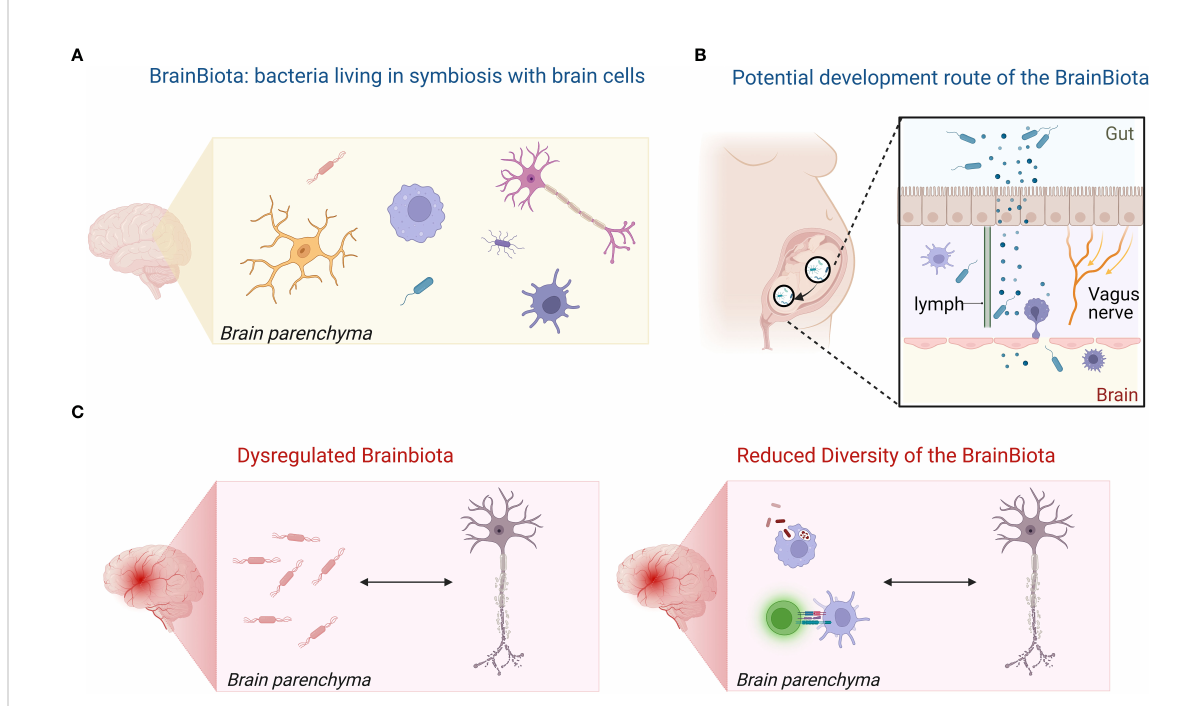
FIGURE 2 Hypothesis of the BrainBiota and its role in MS. (A) The healthy brain has a microbiota (BrainBiota). (B) The BrainBiota overlaps with the gut microbiome as it originates from the early gut microbiome. (C) Dysregulated BrainBiota may contribute and maintain chronic in fl ammation in brain diseases or be the result of the in fl ammatory milieu.Illustration was created in